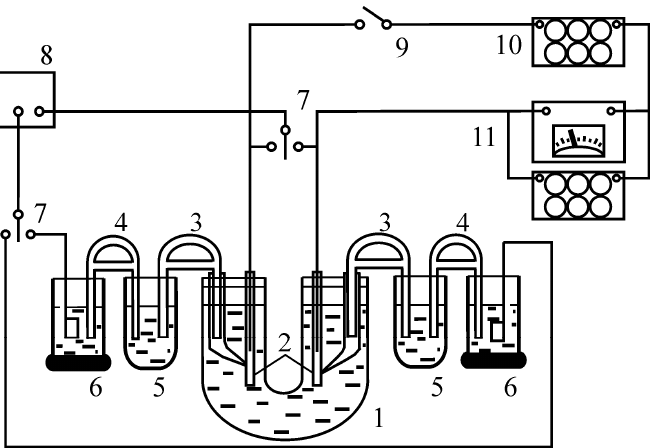
Figure 1. Installation for studying contact corrosion of metals: 1—U-shaped vessel; 2—test samples; 3—electrolytic keys with the test solution; 4—electrolytic keys with saturated KCl solution; 5—intermediate glasses with the test solution; 6—saturated silver chloride electrodes; 7—switches; 8—potentiometer; 9—knife switch; 10—resistance box; 11—microammeter with a shunt resistance box. Using a digital voltmeter, the potentials of the electrodes were measured, and their